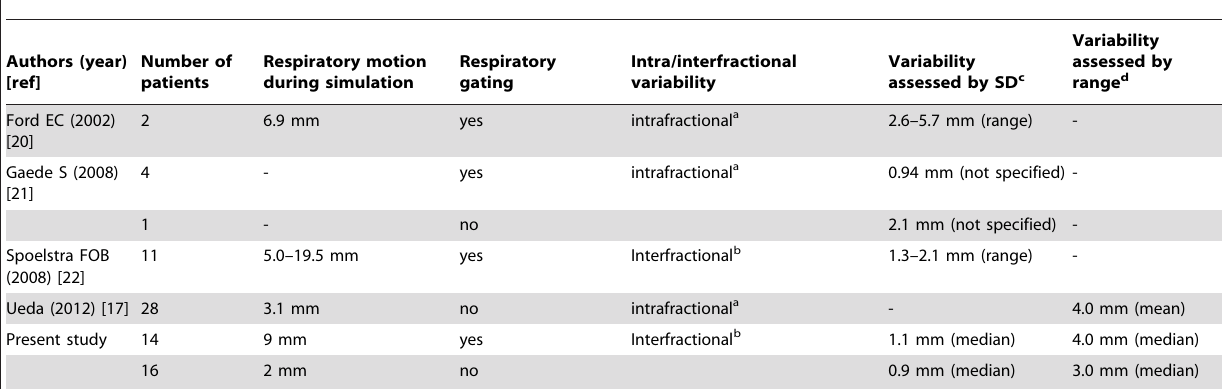
Table 1. Earlier reports on the variability of the lung tumor position evaluated on EPID